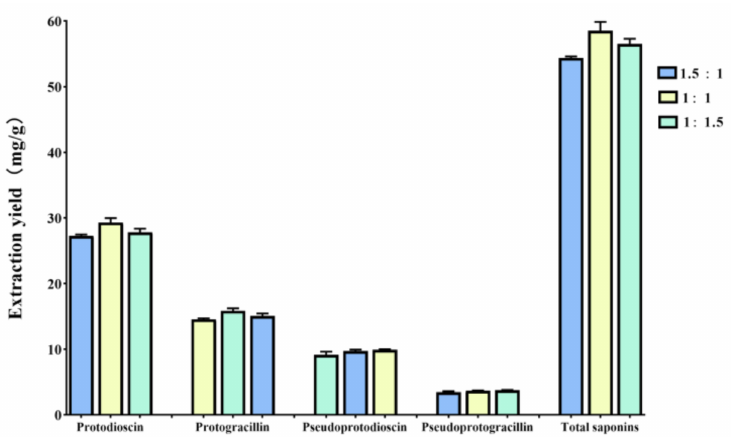
Figure 3. Extraction yields of different molar ratios (1.5:1, 1:1, and 1:1.5) of ChCl-Mal for protodioscin, protogracillin, pseudoprotodioscin, pseudoprotogracillin, and four total steroidal saponins. Error bars indicate the standard deviation ( n =